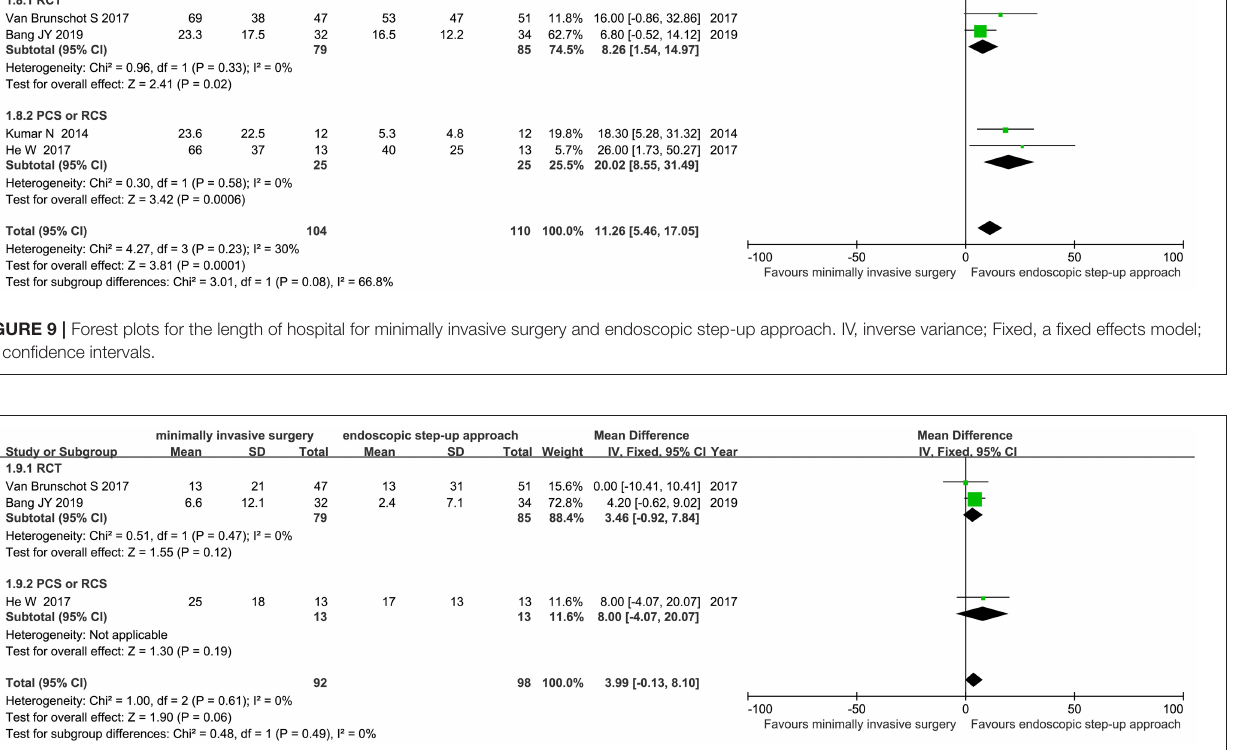
FIGURE 10 | Forest plots for ICU duration of minimally invasive surgery and endoscopic step-up approach. IV, inverse variance; Fixed, a fixed effects model; CI, confidence